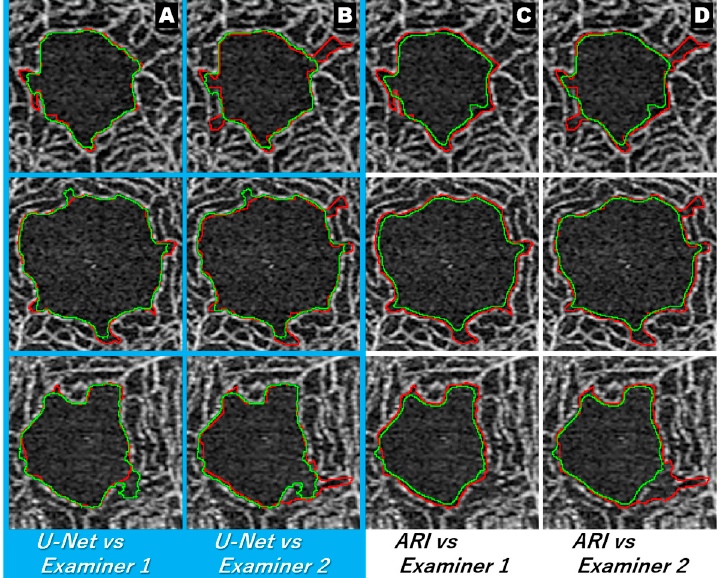
Figure 6. Superimposed images of the extraction lines of each automatic method and each manual method. Extraction lines for each automatic method (green line for U-Net and ARI). Extraction line for each manual method (red line). The extraction lines of examiners 1 and the U-Net demarcated almost the same area, except for the uneven area (column ( A )). The extraction lines of examiners 2 and the U-Net appear to cross each other (column ( B )). The extraction line for ARI looks smaller than any of the examiners (columns ( C , D )). ARI: Advanced Retina Imaging.